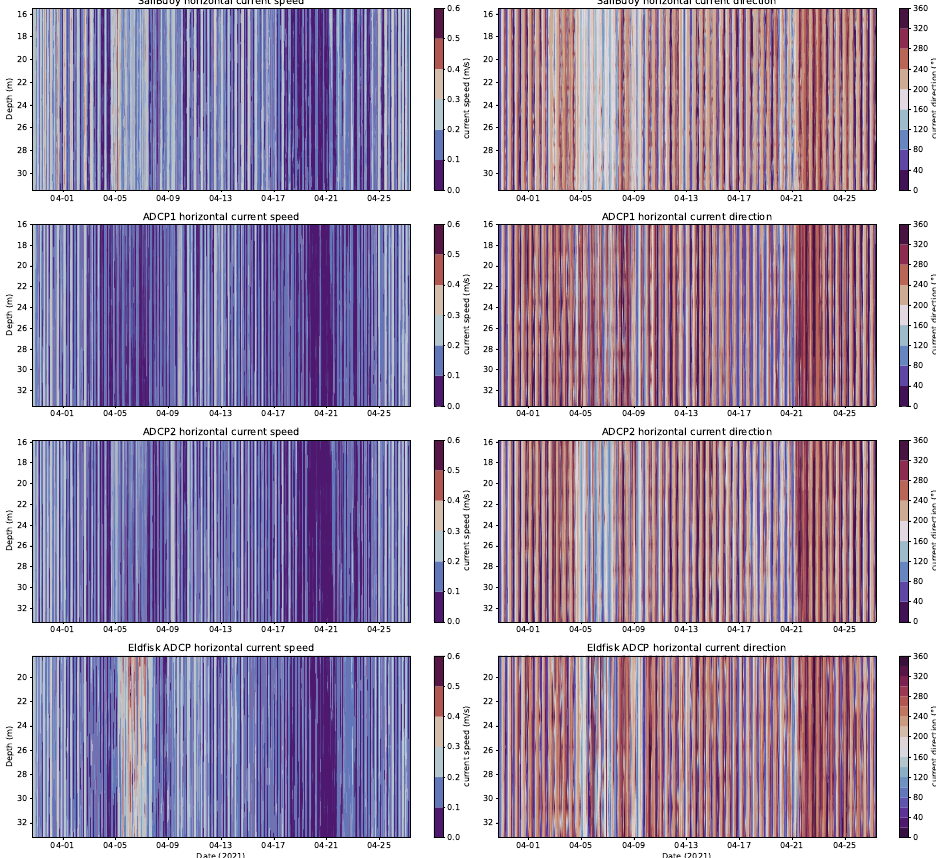
Figure 9. Current speed ( left ) and direction ( right ) measurements of the four profilers (SB, ADCP1 and 2, and Eldfisk) during the Ekofisk validation campaign in April 2021 showing results from approx. the same depth